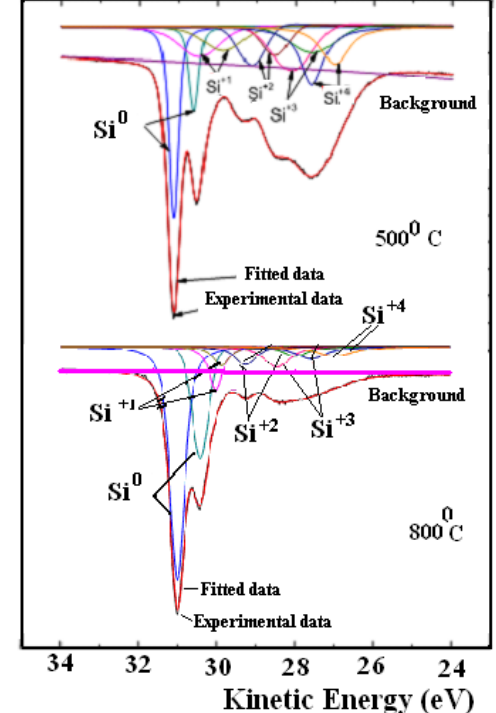
Fig. 3. Fit of Si 2p spectrum of Si (100)- 2x1 exposed to 40 min O at 500 0 C (up) and 800 0 C 2